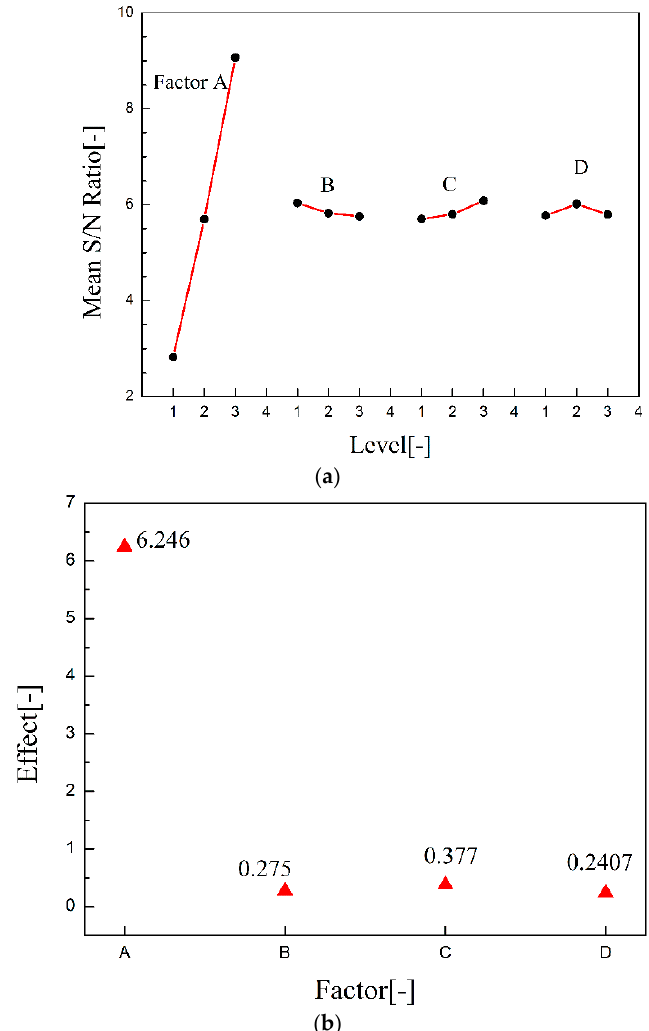
Figure 16. ( a ) Profiles of mean S/N ratio; and, ( b ) factor effect value versus factors.